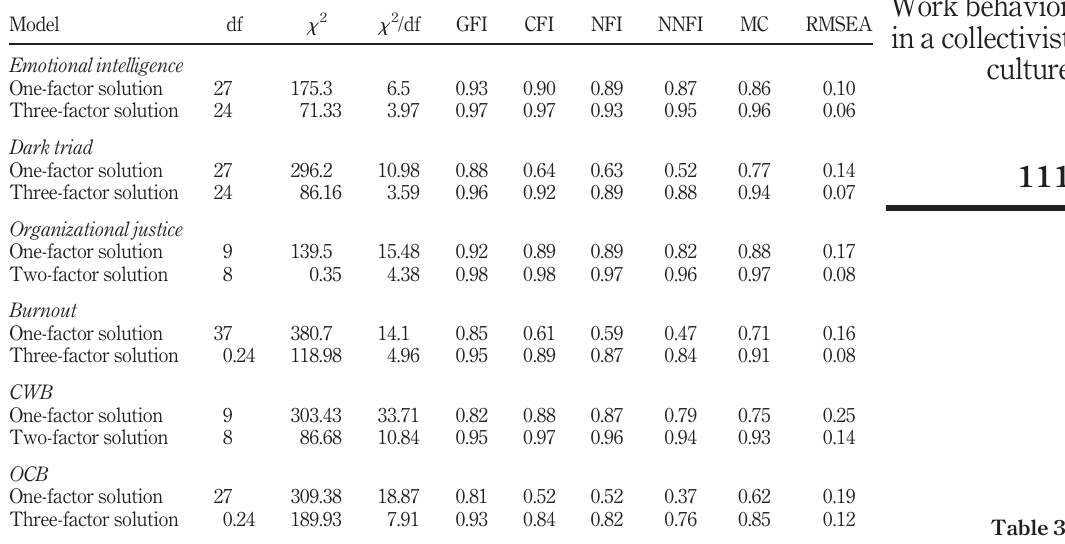
Table 3. Con fi rmatory factor analysis of research variables ( N =